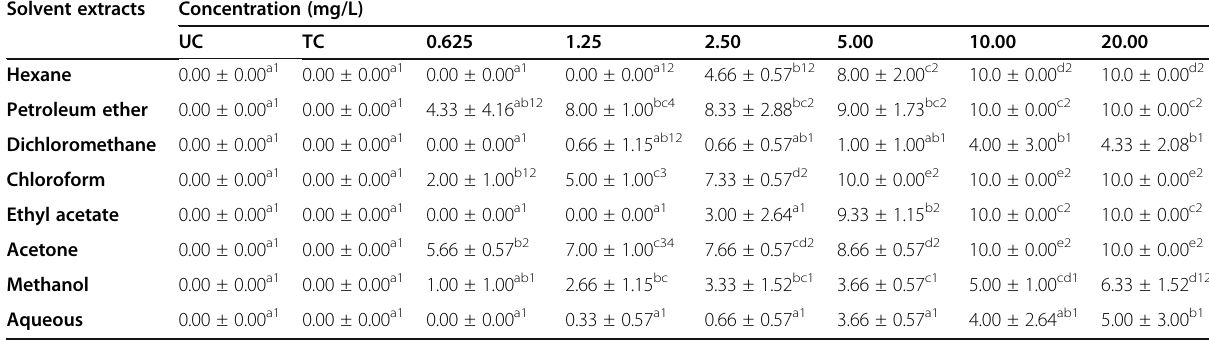
Table 3 Adulticidal activity of Nicotiana tabacum leaf extracts against Sitophilus oryzae at 24 h Solvent extracts